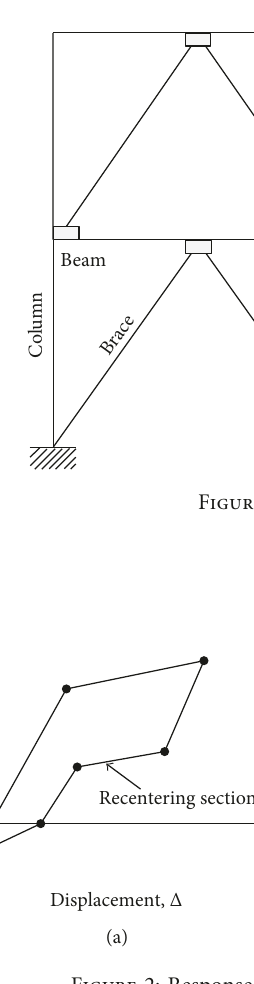
Figure 2: Response mechanism. (a) SMA behavior. (b) Steel behavior. (c) Total